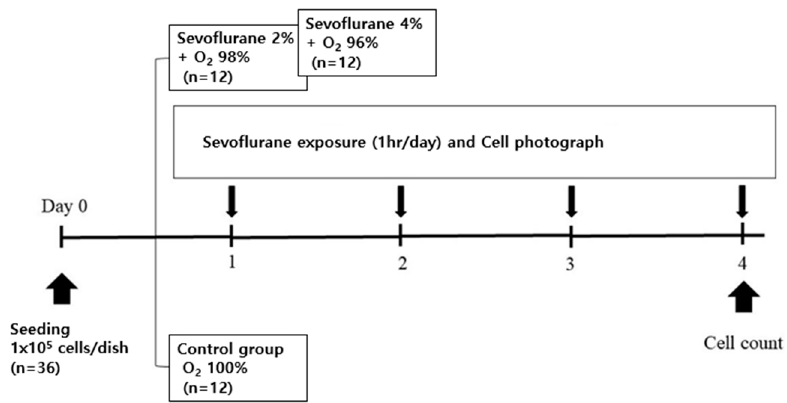
Figure 1. Schematic illustration for the in vitro study with oxygen.